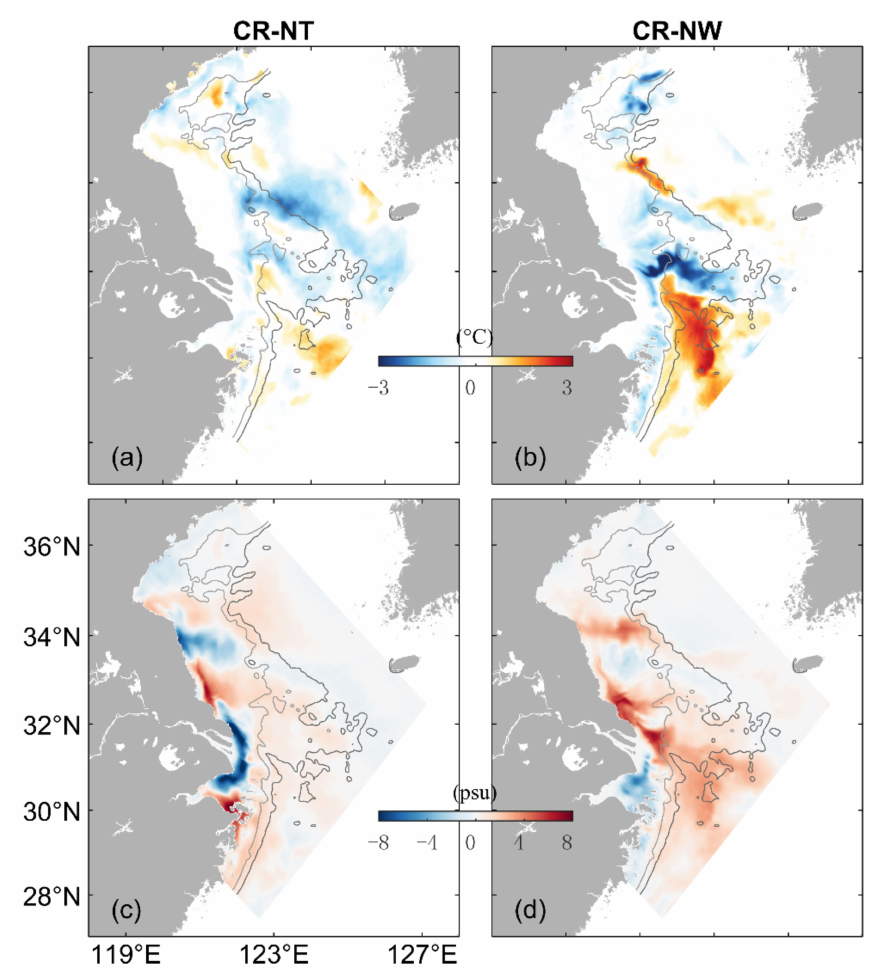
Figure 12. Differences in the simulated monthly mean SST ( a , b ) and SSS ( c , d ) between cases CR and NT ( a , c ) and between cases CR and NW ( b , d ) in February 2015. The light grey and dark grey contours are isobaths of 30 m and 50 m